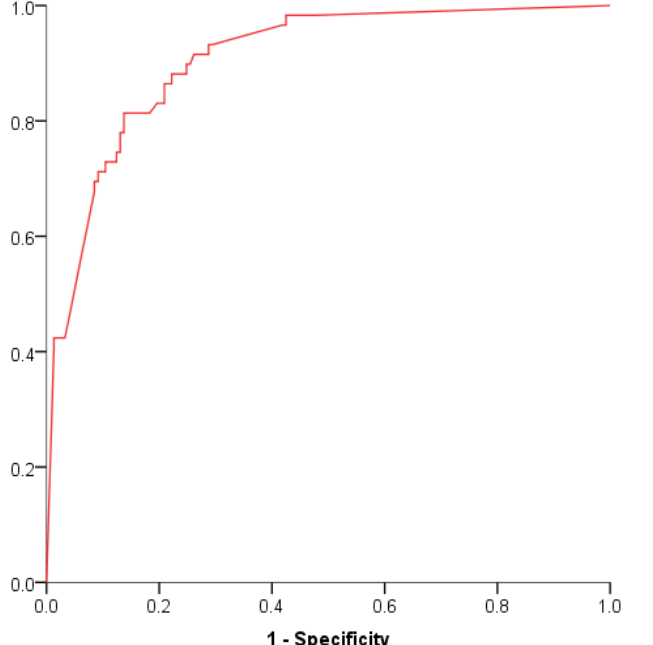
Figure 2. Receiver operating characteristic (ROC) curve for the different biomarkers. Figure 2 . Receiver operating characteristic (ROC) curve for the different biomarkers